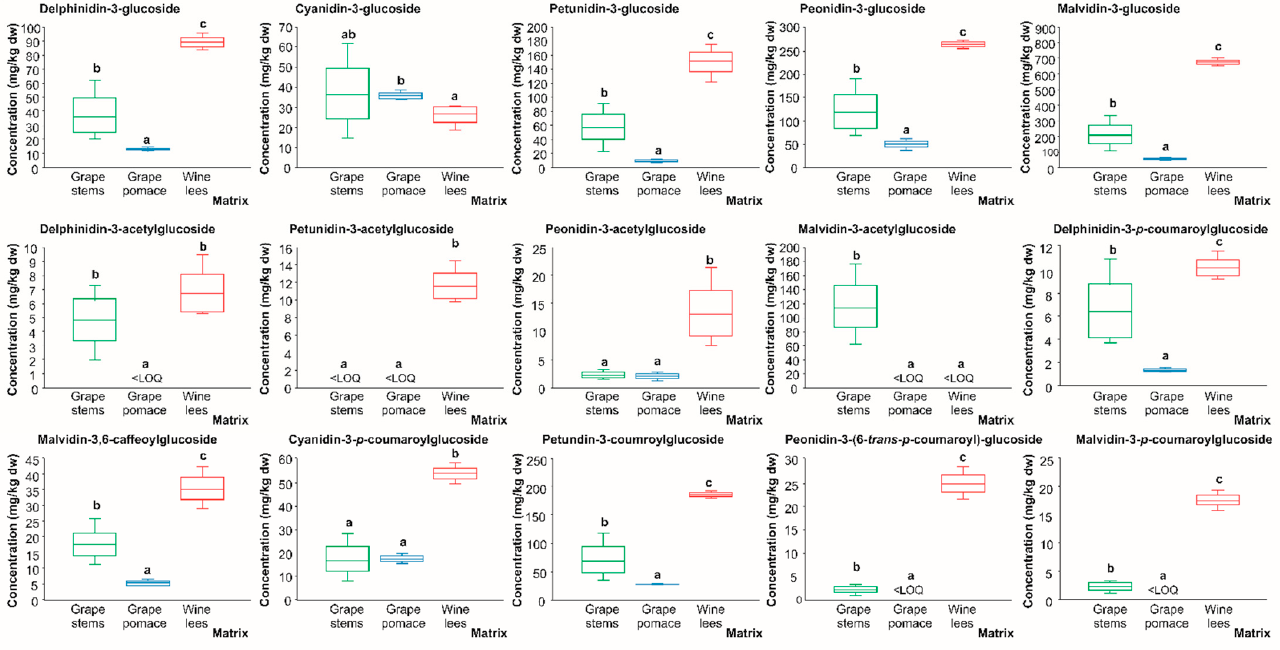
Figure 10. Box plots with quartiles (upper values 75%, median 50%, and lower values 25%) of individual anthocyanins (mg/kg dw) of (poly)phenolic extracts of grape stems (green box), grape pomace (blue box), and wine lees (red box). Boxes with a different letter (a,b,c) within each plot indicate statistically significant differences according to the one-way analysis of variance (ANOVA) and Tukey’s multiple range test. <LOQ, lower than the limit of quantification.